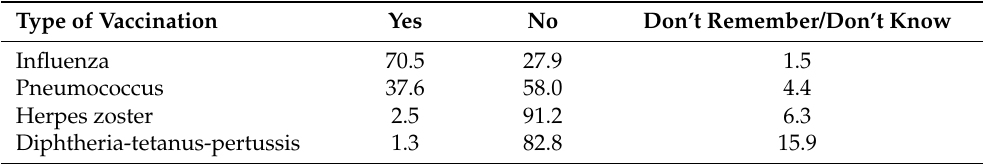
Table 2. Frequency of vaccinations in the participants